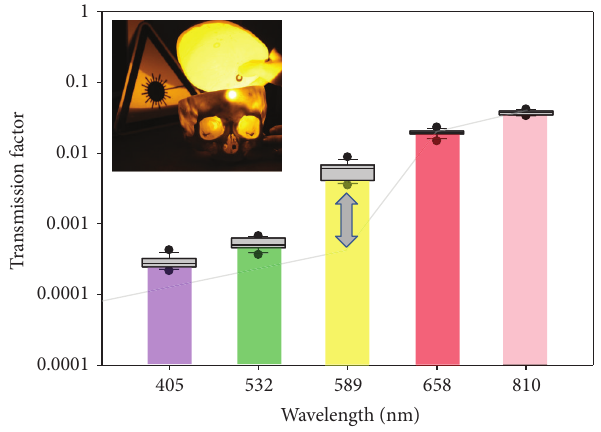
Figure 3: Box plot diagram showing measurement values (box plot) and the schematic results of the previous study (light grey line) concerning the violet (405nm), green (532nm), yellow (589nm), red (658 nm), and infrared (810nm) laser. The lines in the boxes represent the median, the ends of the boxes define the 25th and 75th percentile, and the error bars define the 10th and 90th percentile. The arrow indicates the variation between our measured values and the estimated values of the previous study